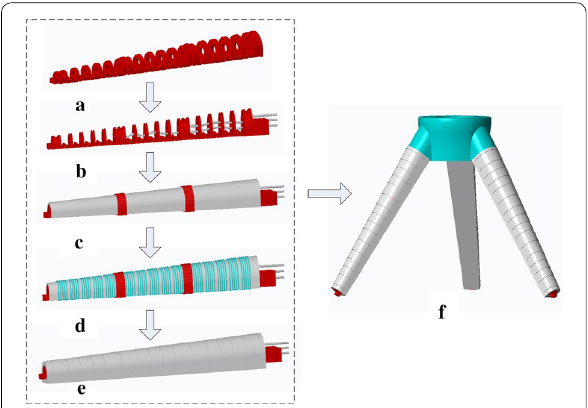
Figure 5 Fabrication progress of the E-Gripper. a The endoskeleton consists of several basic units. b Three tubes are embedded into the endoskeleton. c One silicon rubber layer is glued around the endoskeleton, and the seal rings are sealed. d Circumferential fiber is evenly wound on the surface. e A complete soft finger. f